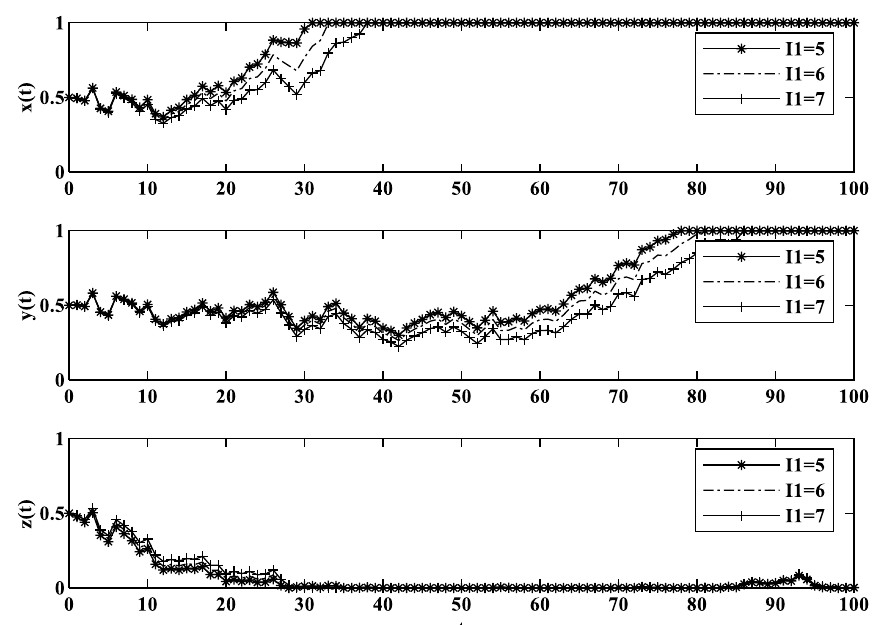
Fig. 12 Impact of supervise incentives on evolutionary process under scenario